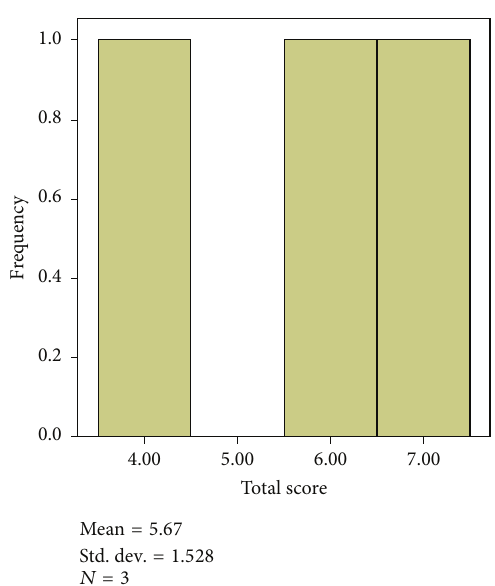
Figure 2: Histogram of total score of